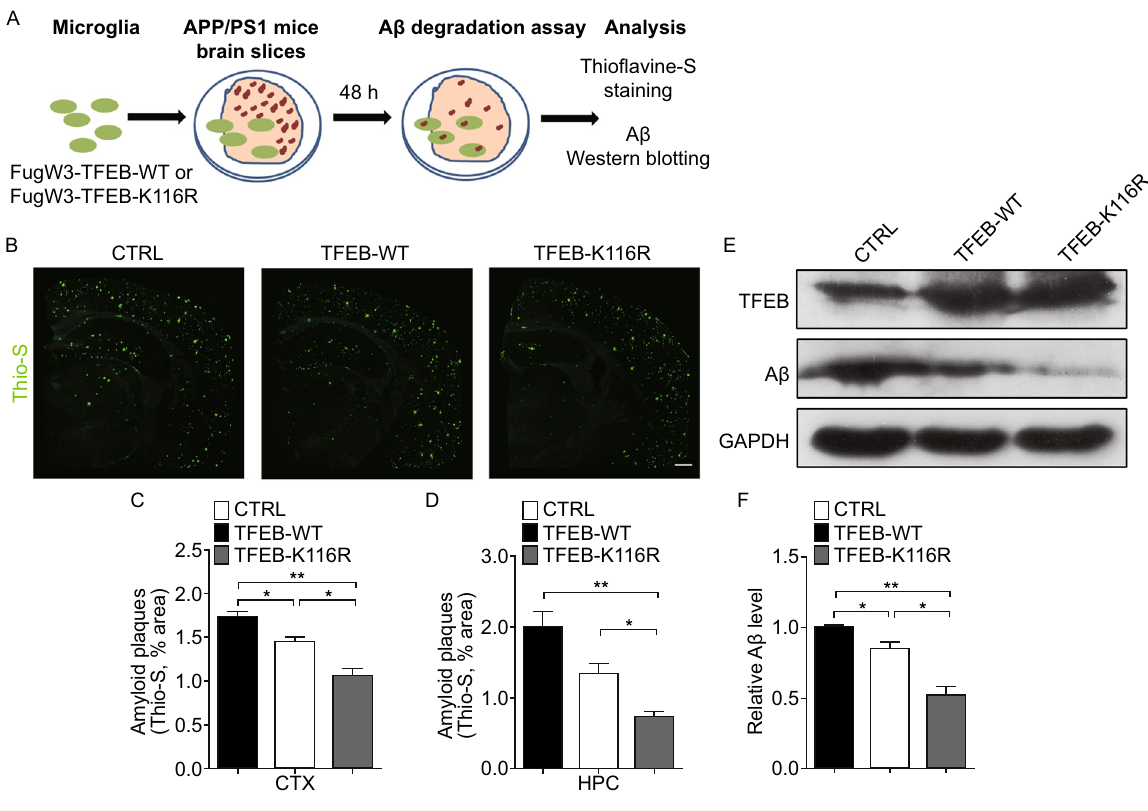
Figure 7. Microglial expression of deacetylated TFEB reduces amyloid plaques in the brain slices from APP/PS1 mice. (A) Ex vivo degradation assay. BV2 microglia were infected with lentivirally overexpressed FugW3-TFEB (WT or K116R) and co- cultured with 10 μ m thick freshly cut, un fi xed brain slices from aged APP/PS1 transgenic mice. After 48 h the slices were used for subsequent analysis. (B – E) Deacetylation of TFEB at K116 further reduces amyloid plaques. BV2 microglia overexpressed with vector control (CTRL) or TFEB (WTor K116R) were co-cultured with brain sections prepared as depicted in (A), followed by staining amyloid plaques with thio fl avine-S (Green) (B – D) or by Western blotting analysis of fA β levels (E and F). CTX, cortex; HPC, hippocampi. Results are mean area fraction of amyloid plaques ± SEM for 3 mice per group. The band intensity was measured in three independent experiments indicating relative fA β levels and the mean ± SEM. One-way ANOVA with Turkey ’ s test, * P < 0.05; ** P < 0.01. Scale bar, 200 μ